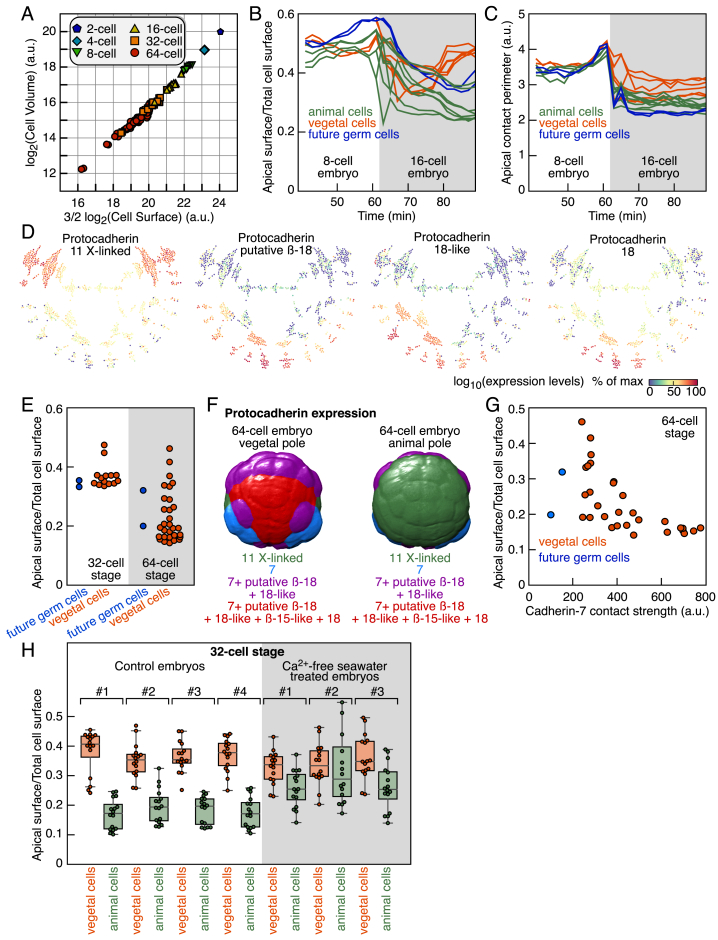
Morphological Changes and Patterned Expression of Cell Adhesion Molecules, Related to Figure 5(A) Comparison between cell volume and surface as measured by SPIM imaging from 2-cell to 64-cell stages (r = 0.97 and p = 2.10−76, Pearson’s correlation coefficient).(B) Temporal evolution of the relative apical surface from 8-cell to 16-cell stage as measured by SPIM imaging.(C) Temporal evolution of the apical contact perimeter from 8-cell to 16-cell stage as measured by SPIM imaging.(D) Expression levels of four protocadherins in the different cell types.(E) Relative apical surface of vegetal cells at the 32- and 64-cell stages.(F) Expression territories of six cadherins and protocadherins at the 64-cell stage as measured by scRNA-Seq. Territories were displayed on rendered segmented membrane signal from SPIM imaging.(G) Comparison between the estimated cadherin-7 contact strength and the relative apical surface in animal cells at the 64-cell stage (r = −0.62 and p = 0.0001, Pearson’s correlation coefficient).(H) Relative apical surface of animal and vegetal cells at 32-cell stage of control embryos and embryos treated with Ca2+-free seawater.